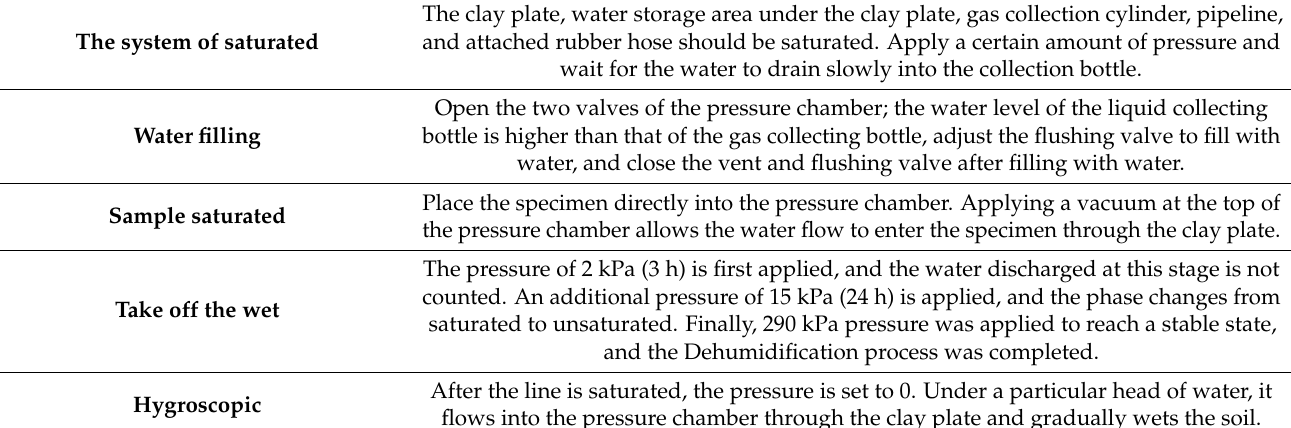
Figure 8. Saturated soil sample. Table 3. The operation flow of unsaturated soil transient in dehumidification and hygroscopic sys- tems.